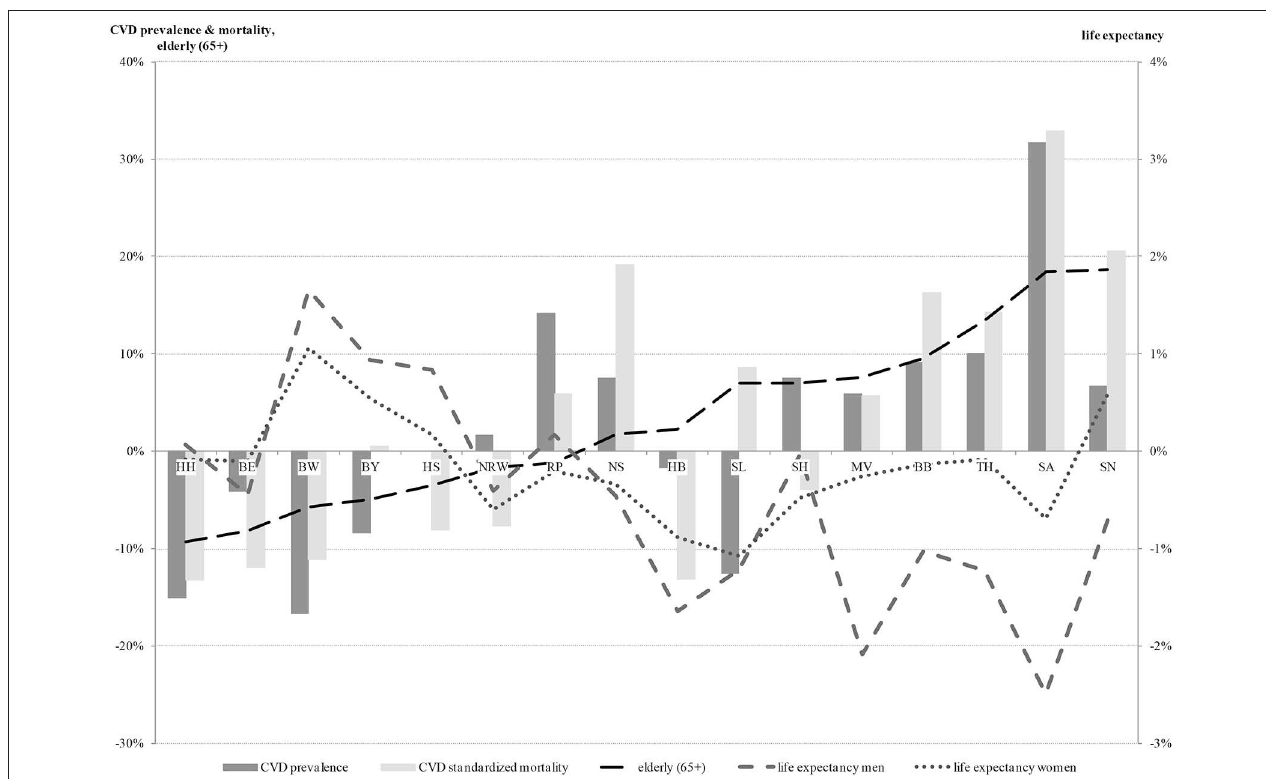
FIGURE 1 | Health indicators in relation to the national average (0%) (ordered by proportion of the elderly). CVD, cardiovascular disease; HH, Hamburg; BE, Berlin; BW, Baden-Württemberg; BY, Bavaria; HS, Hesse; NRW, North Rhine-Westphalia; RP, Rhineland-Palatinate; NS, Lower Saxony; HB, Bremen; SL, Saarland; SH, Schleswig-Holstein; MV, Mecklenburg-West Pomerania; BB, Brandenburg; TH, Thuringia; SA, Saxony-Anhalt; SN,